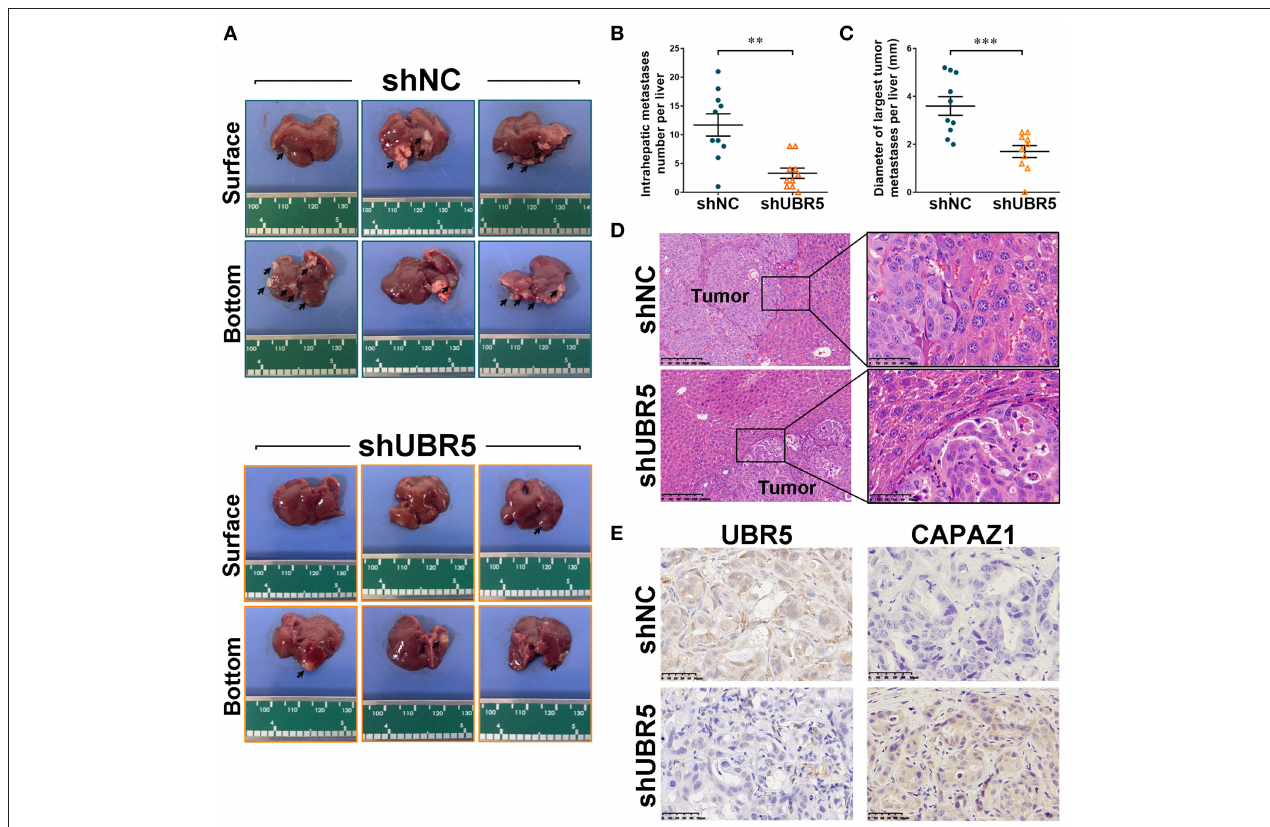
FIGURE 5 | UBR5 deficiency reduces pancreatic cancer metastasis in vivo . (A) Representative images of liver-metastatic lesions from nude mice after injection of CFPAC-1 cells infected with shNC or shUBR5 (n = 10 for each group). (B) The number of lesions in shNC and shUBR5 groups. (C) The diameter of the largest metastatic tumor per liver was measured. (D) H&E staining of livers with the metastatic lesions. Scale bar of left panels: 200 µ m; Scale bar of right panels: 50 µ m. (E) IHC staining of UBR5 and CAPZA1 protein expression in the metastatic tumors. Scale bar: 50 µ m. Data represents mean ± SEM (n = 3 independent biological repeats unless otherwise indicated). ** P < 0.01, *** P <